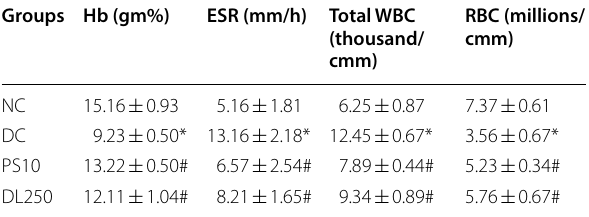
Data represented as mean SEM; * p < 0.05 compared to NC group and ± # p < 0.05 compared to DC group (one-way ANOVA followed by Tukey’s multiple